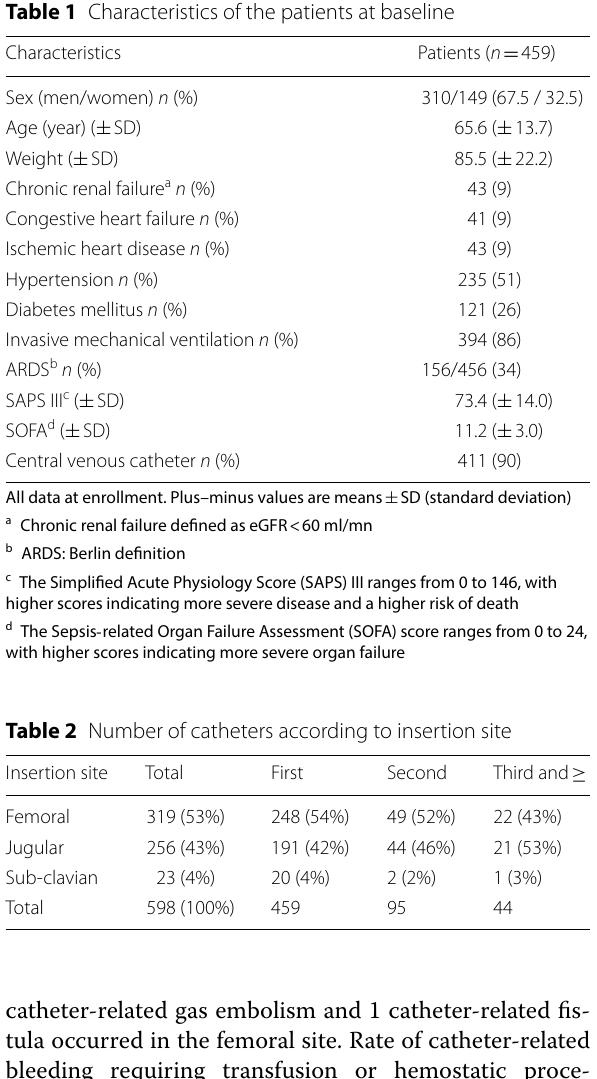
Table 1 Characteristics of the patients at baseline